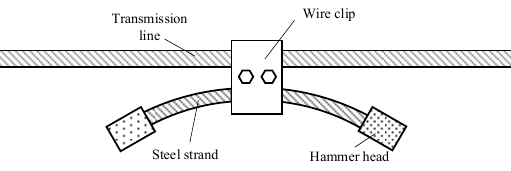
Figure 1. Schematic drawing of a Stockbridge damper.